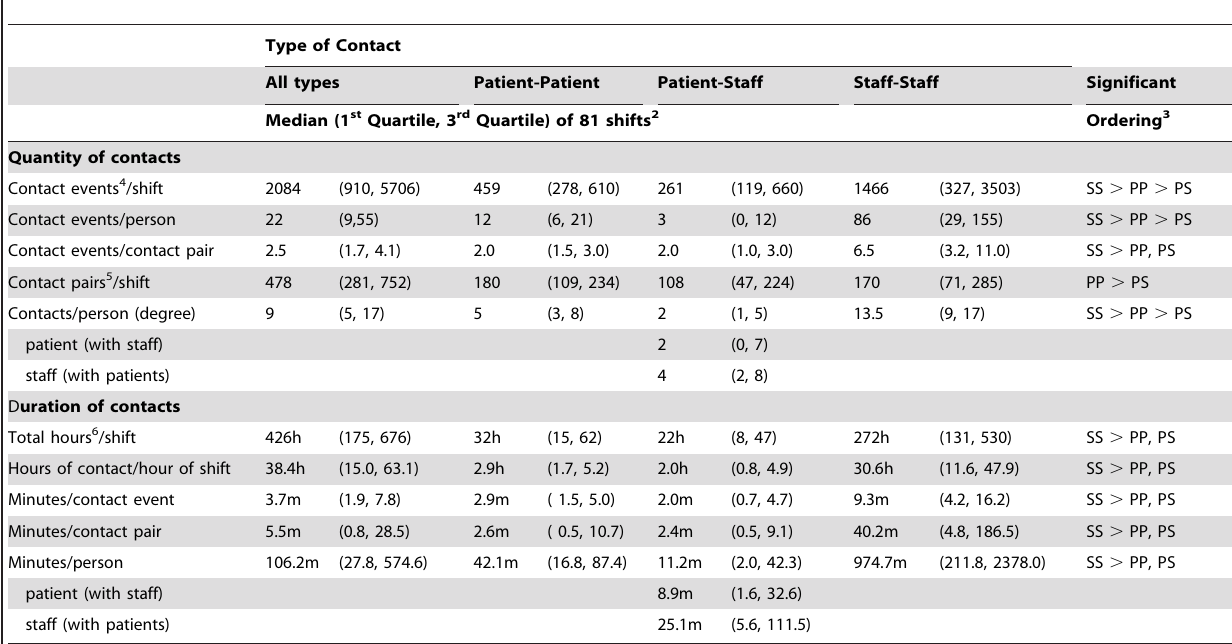
Table 2. Summary of contact characteristics per shift among patients and staff in an Emergency Department, over 81 shifts 1 .